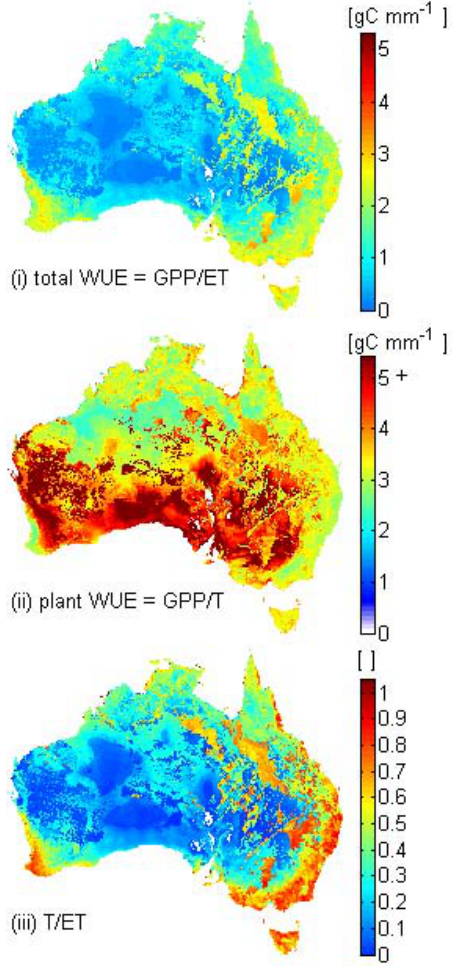
Fig. 14. Maps of long-term (1990–2011) total WUE (i) and its fac- tors: transpiration use efficiency (ii) and fraction of ET which is transpiration (iii).